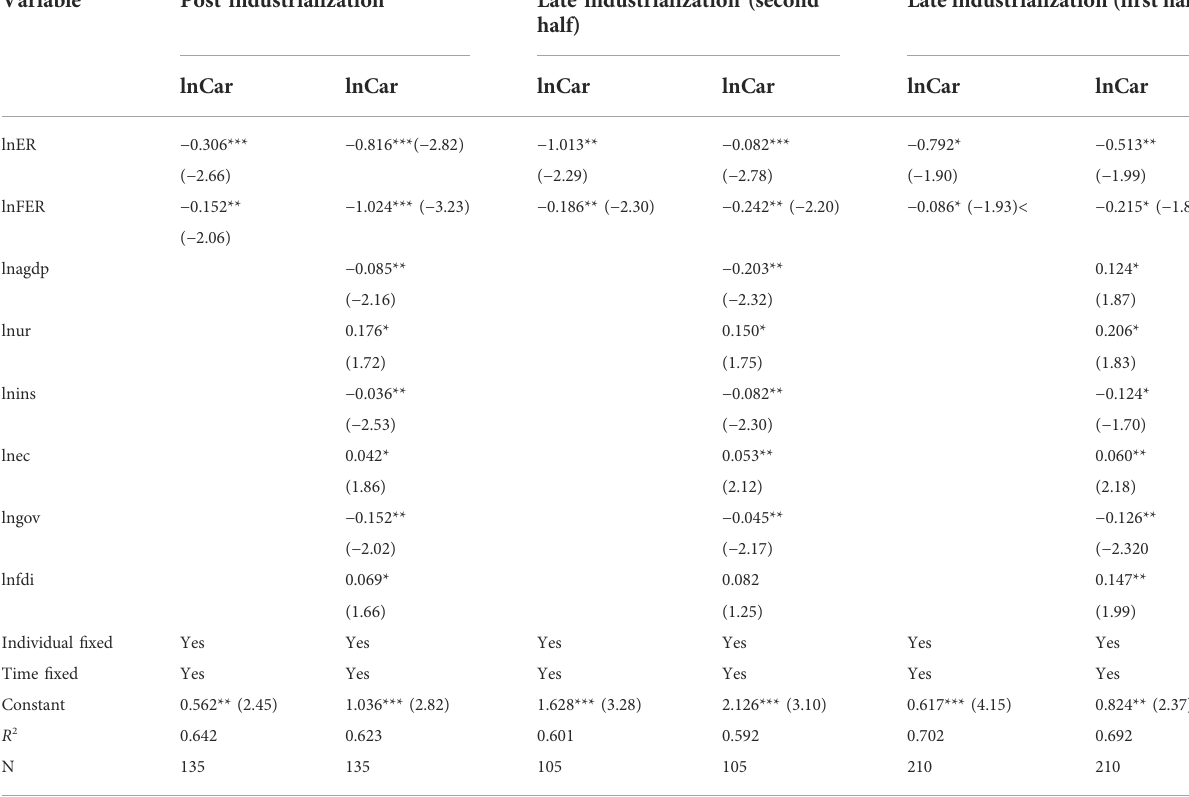
TABLE 5 Regression results of the impact of industrialization development stage.